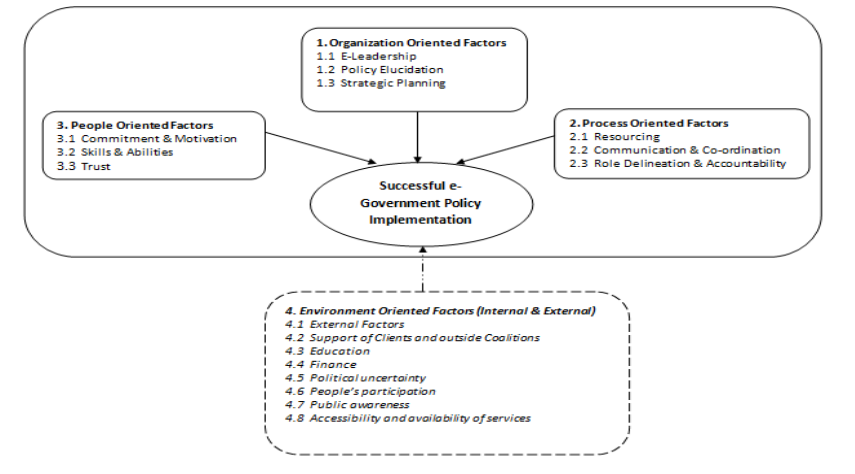
Figure 1: Conceptual